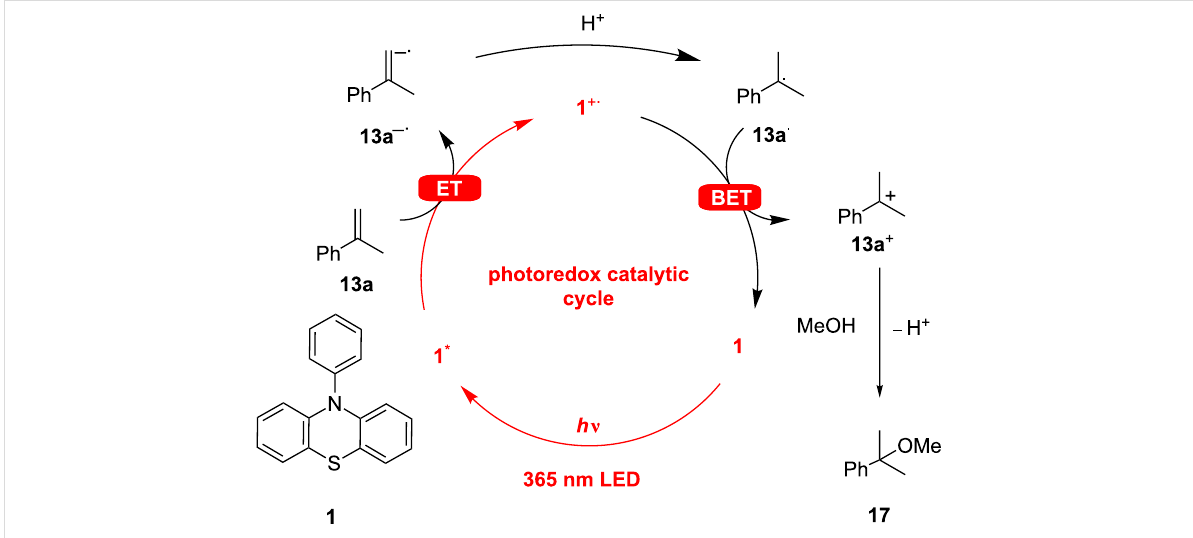
Figure 4: Proposed mechanism for the photoredox-catalyzed addition of methanol to α -methylstyrene ( 13a ). (ET = electron transfer, BET = back-electron transfer).